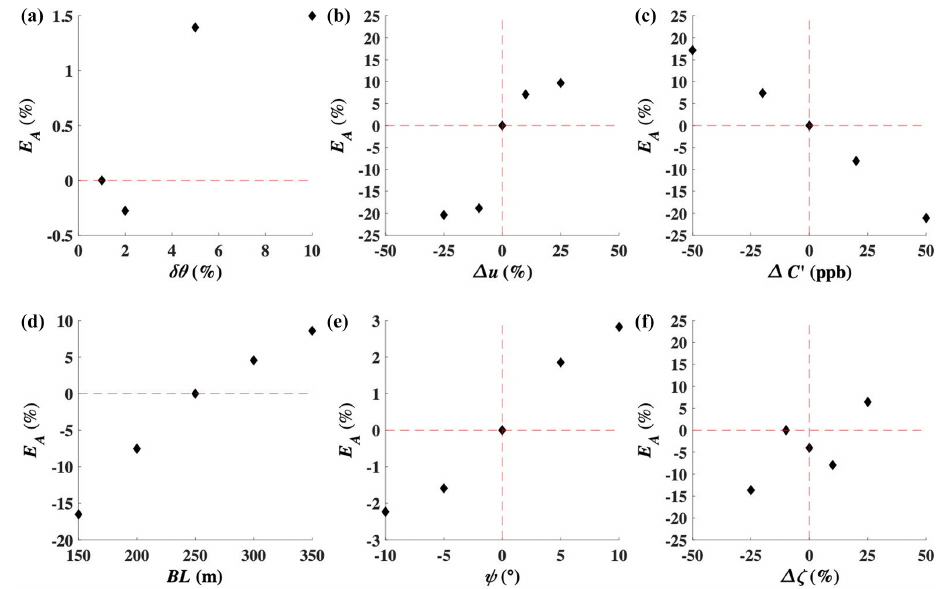
Figure 9. Atmospheric emissions, E A , sensitivity to uncertainty in (a) model angular resolution, δθ , (b) wind speed variation, (cid:49)u , (c) con- centration anomaly variation, (cid:49)C (cid:48) , (d) boundary layer thickness, BL, (e) wind veering, ψ , and (f) inshore–offshore partition variation, (cid:49)ζ . Note that there are different units in different plots. See text for details.